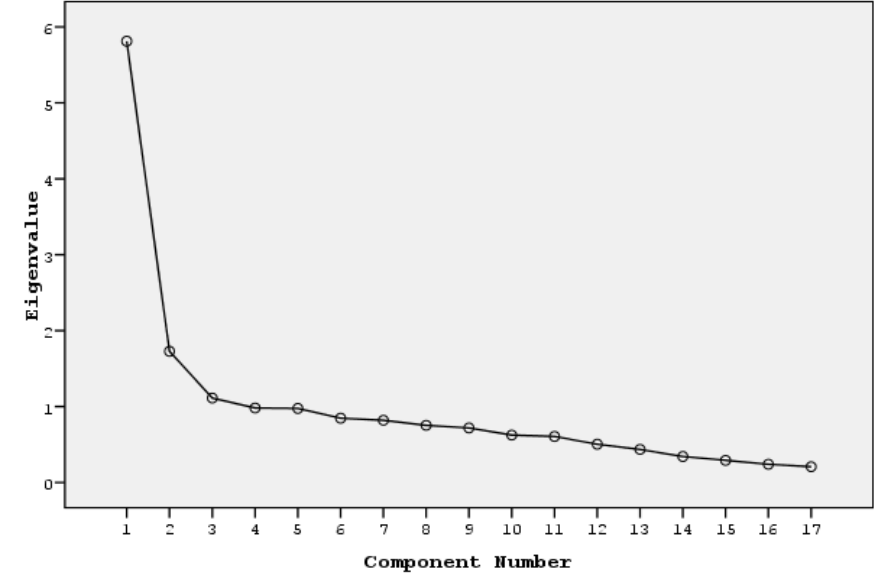
Fig. 1. Curved Accumulation Graph (Eigenvalues with respect to